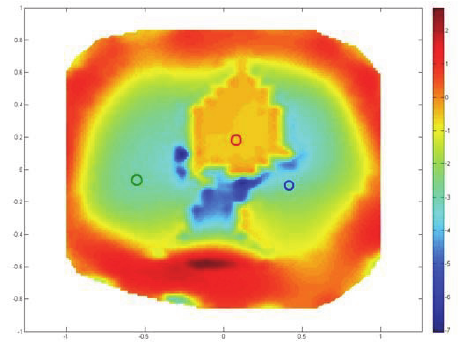
Fig. 13: Locations of 3 representative pixels in grids based on